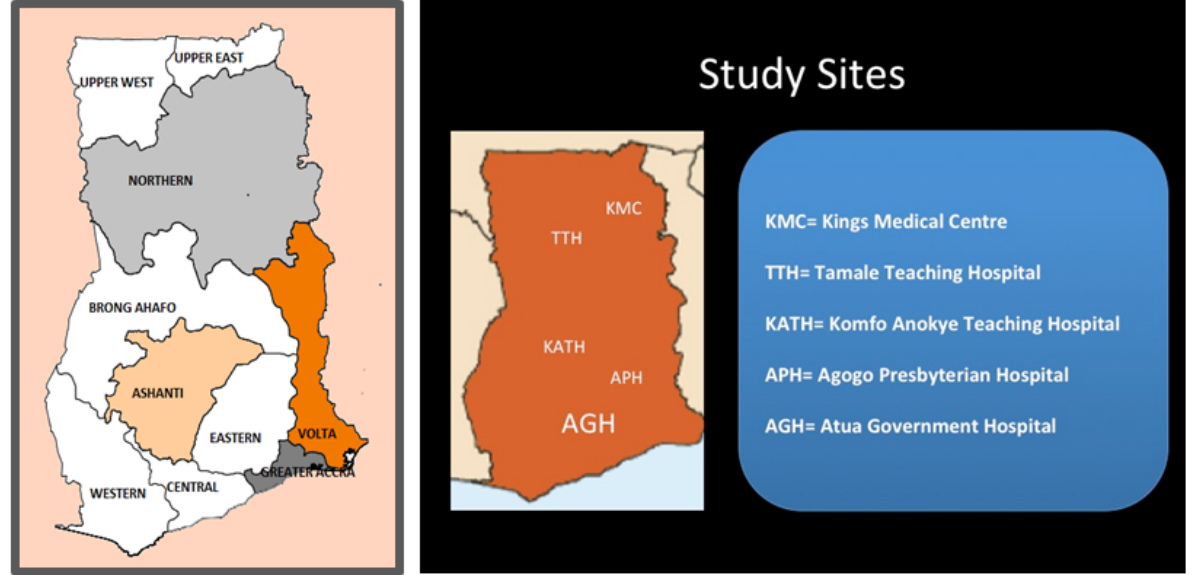
Figure 1. Map of Ghana with regions, with location of target